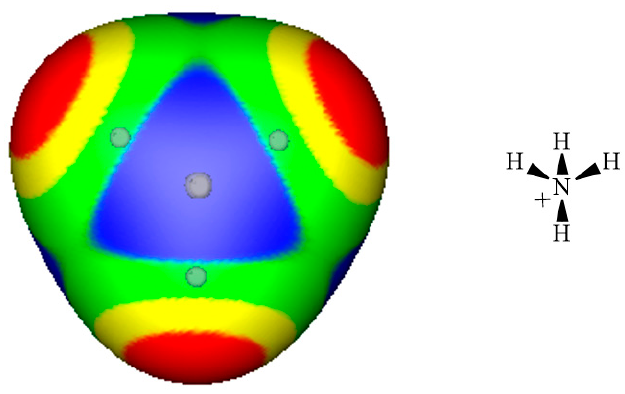
Figure 5. Computed electrostatic potential on 0.001 au cationic surface of NH 4+ cation. Color ranges, in kcal/mol, are: red, greater than 178; yellow, between 178 and 174; green, between 174 and 168; blue, less than 168. Circles show positions of atoms. Most positive potentials are 181 kcal/mol by hydrogens.